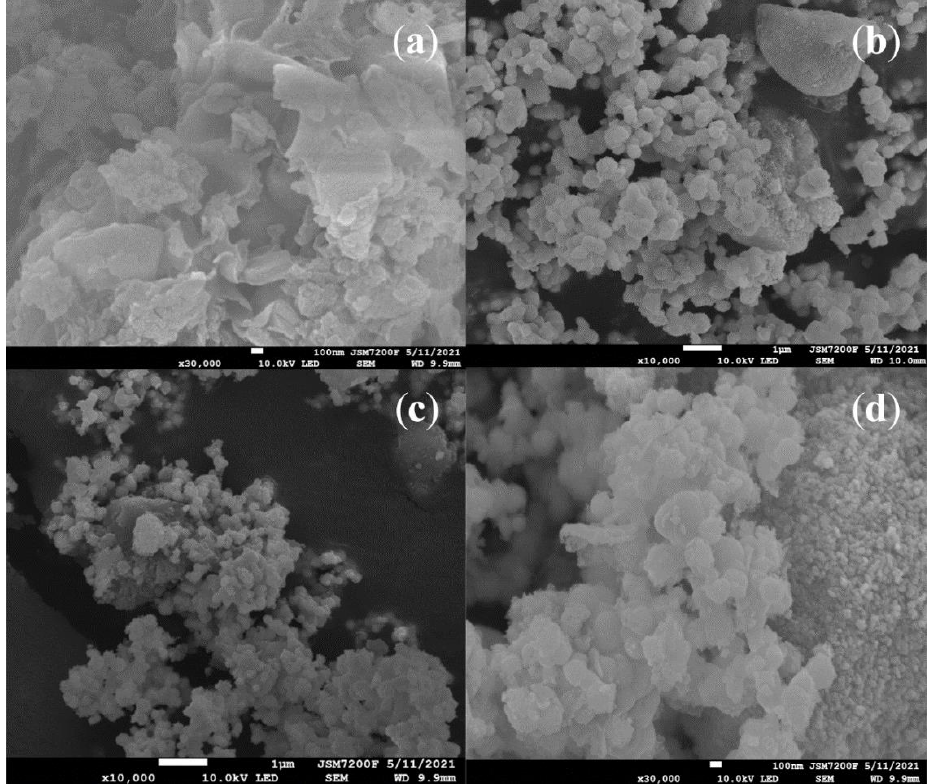
Figure 3. SEM images of ( a ) g-C 3 N 4 , ( b ) Ag 3 PO 4 /TiO 2 , and ( c , d ) g-C 3 N 4 /Ag 3 PO 4 /TiO 2 .